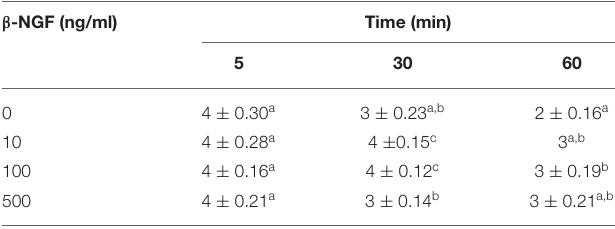
TABLE 3 | Percentage of llama sperm vigor (scale 0–5) after incubation with exogenous β -NGF. β -NGF (ng/ml)